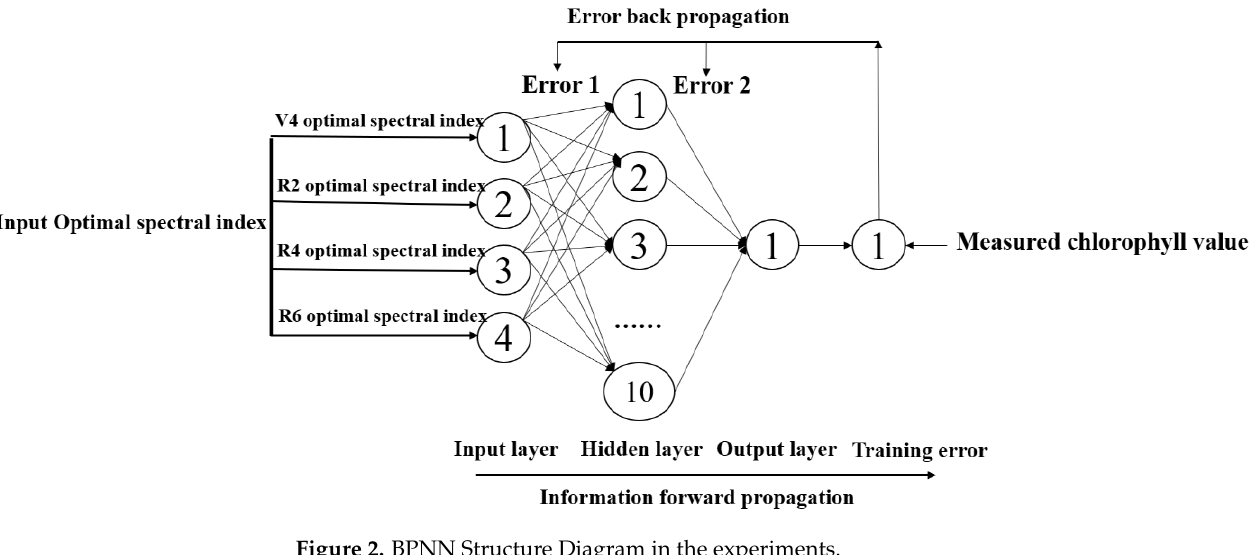
Figure 2. BPNN Structure Diagram in the experiments.